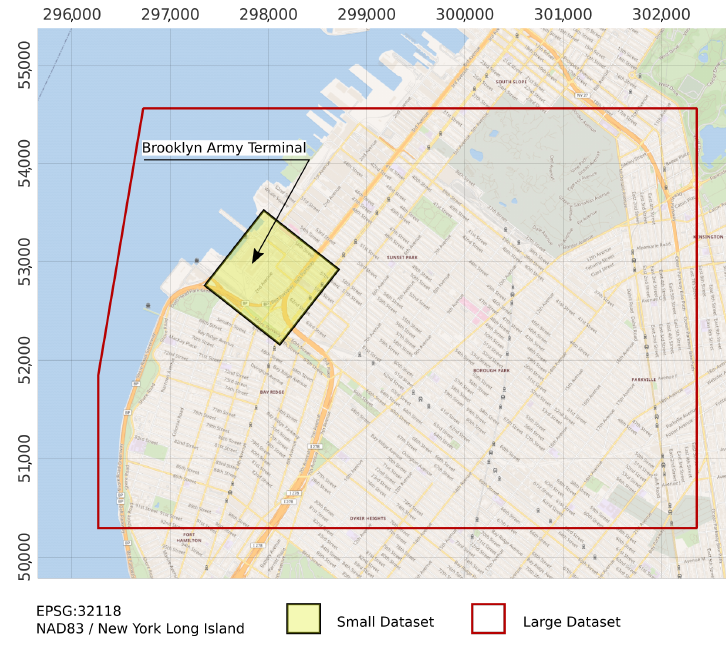
Figure A1. Plan view of spatial extent of the 460 million point